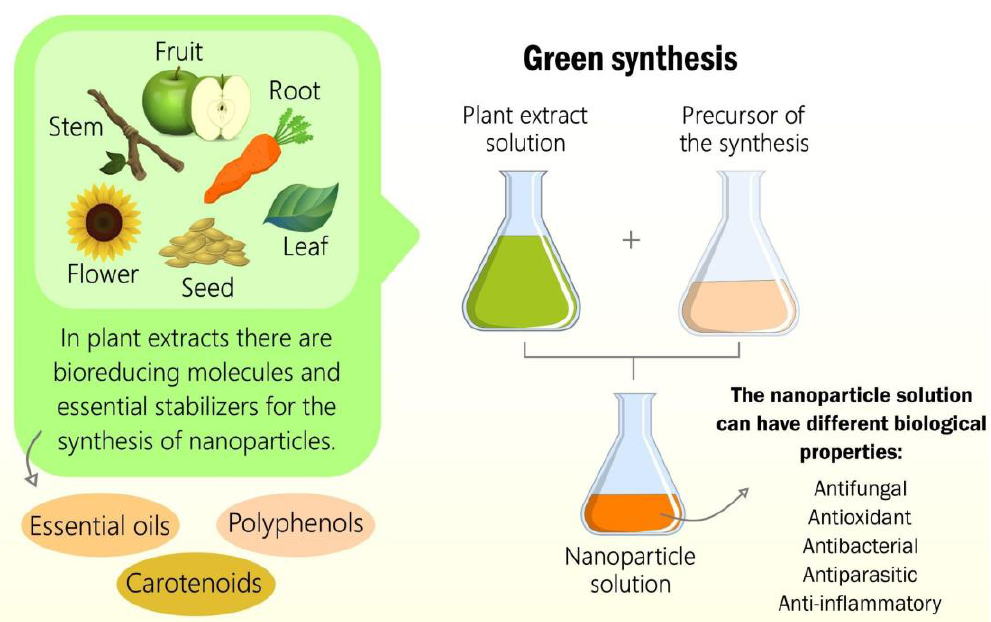
Figure 3. The green synthesis of nanomaterials from plant extracts with different biological proper- ties.